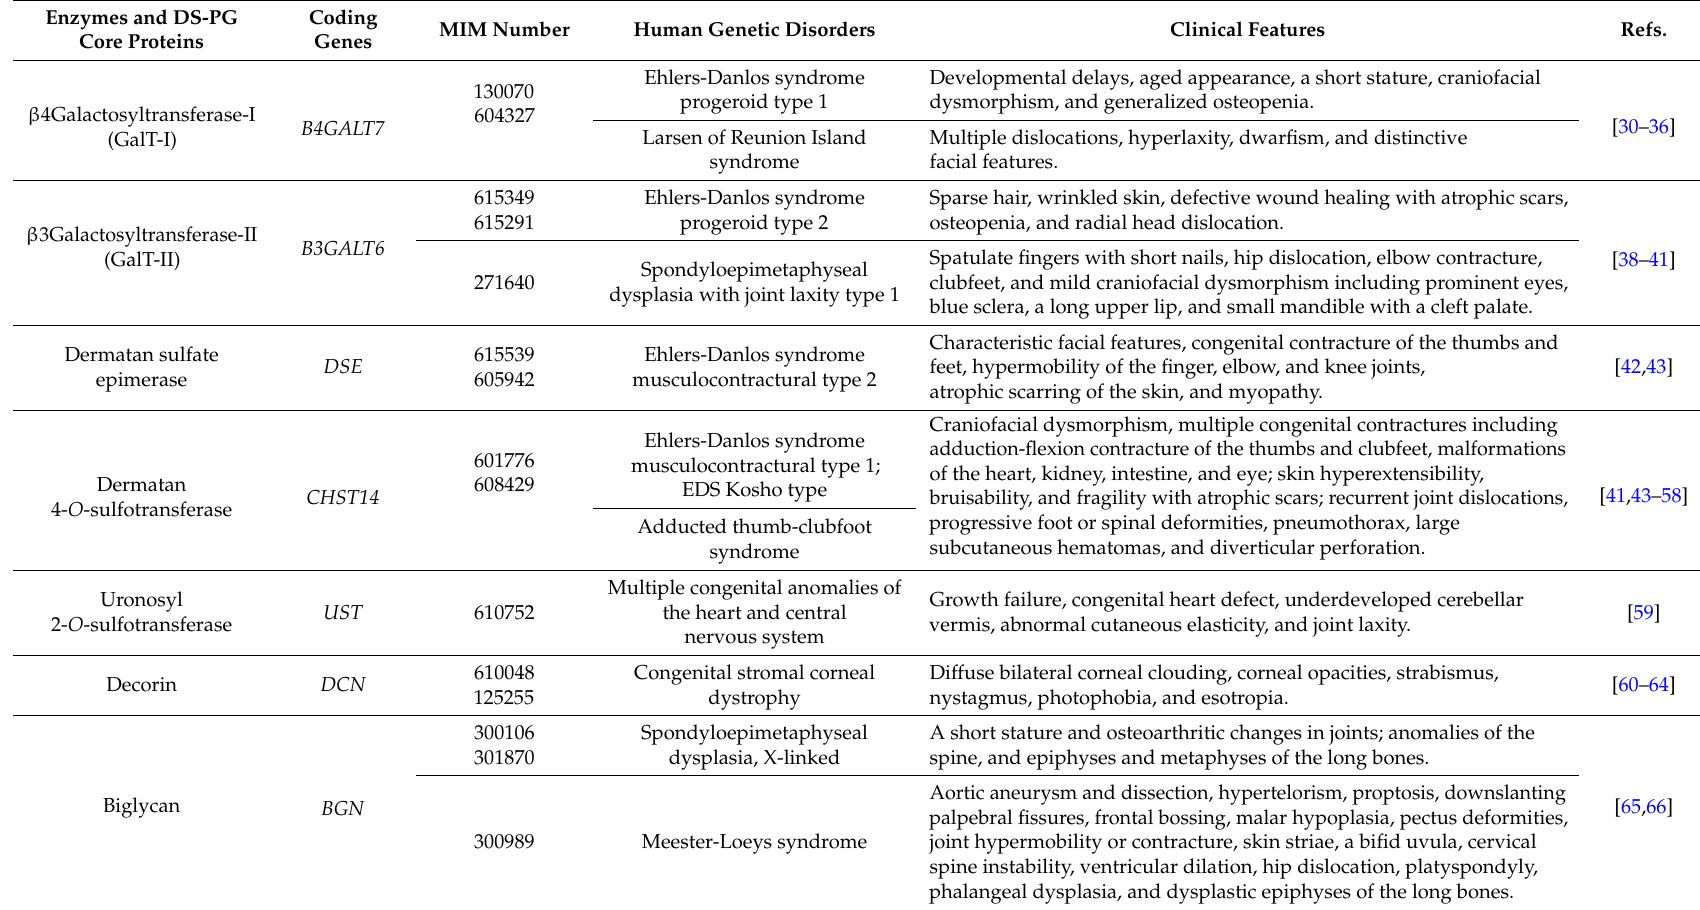
Table 1. Human genetic disorders caused by defects in DS chains and core proteins of DS-PGs. B4GALT7, beta1,4-galactosyltransferase 7;